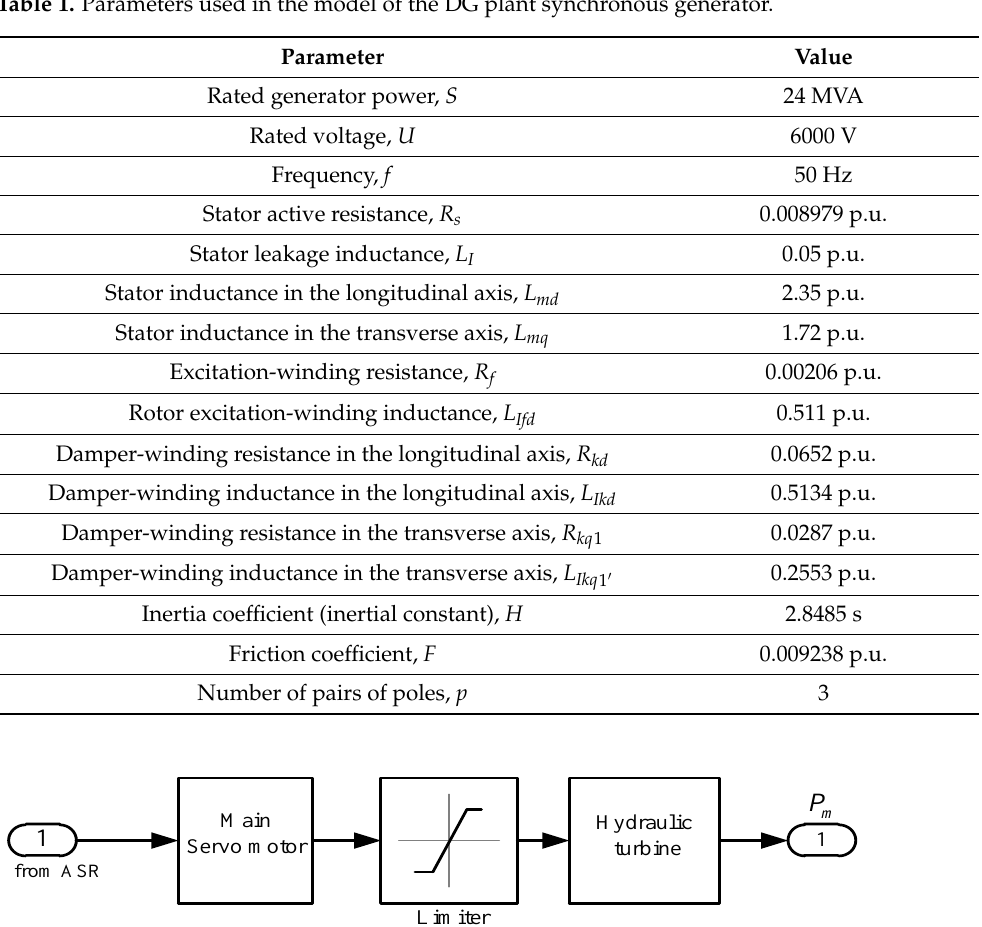
Table 1. Parameters used in the model of the DG plant synchronous generator.